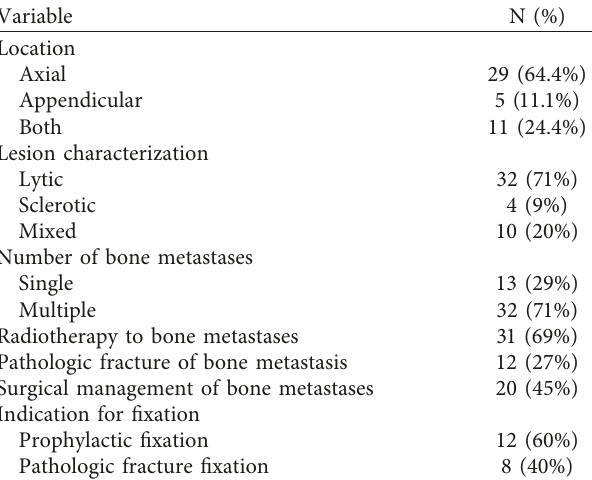
Table 3: Characterization of bone